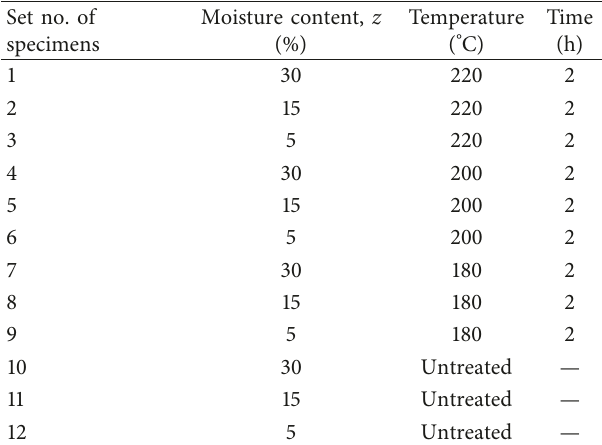
Table 1: The specimen conditions and heating parameters of the